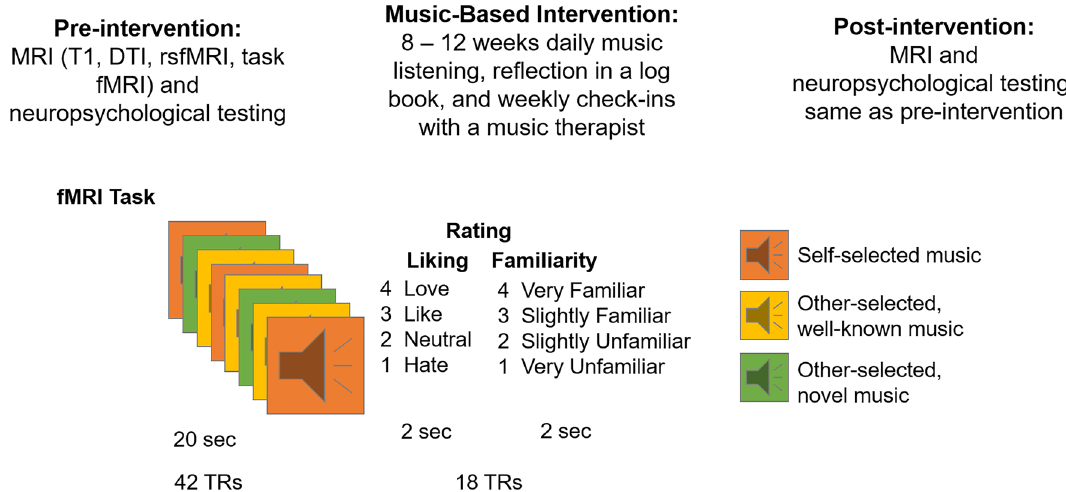
Figure 1. Study timeline and fMRI experiment